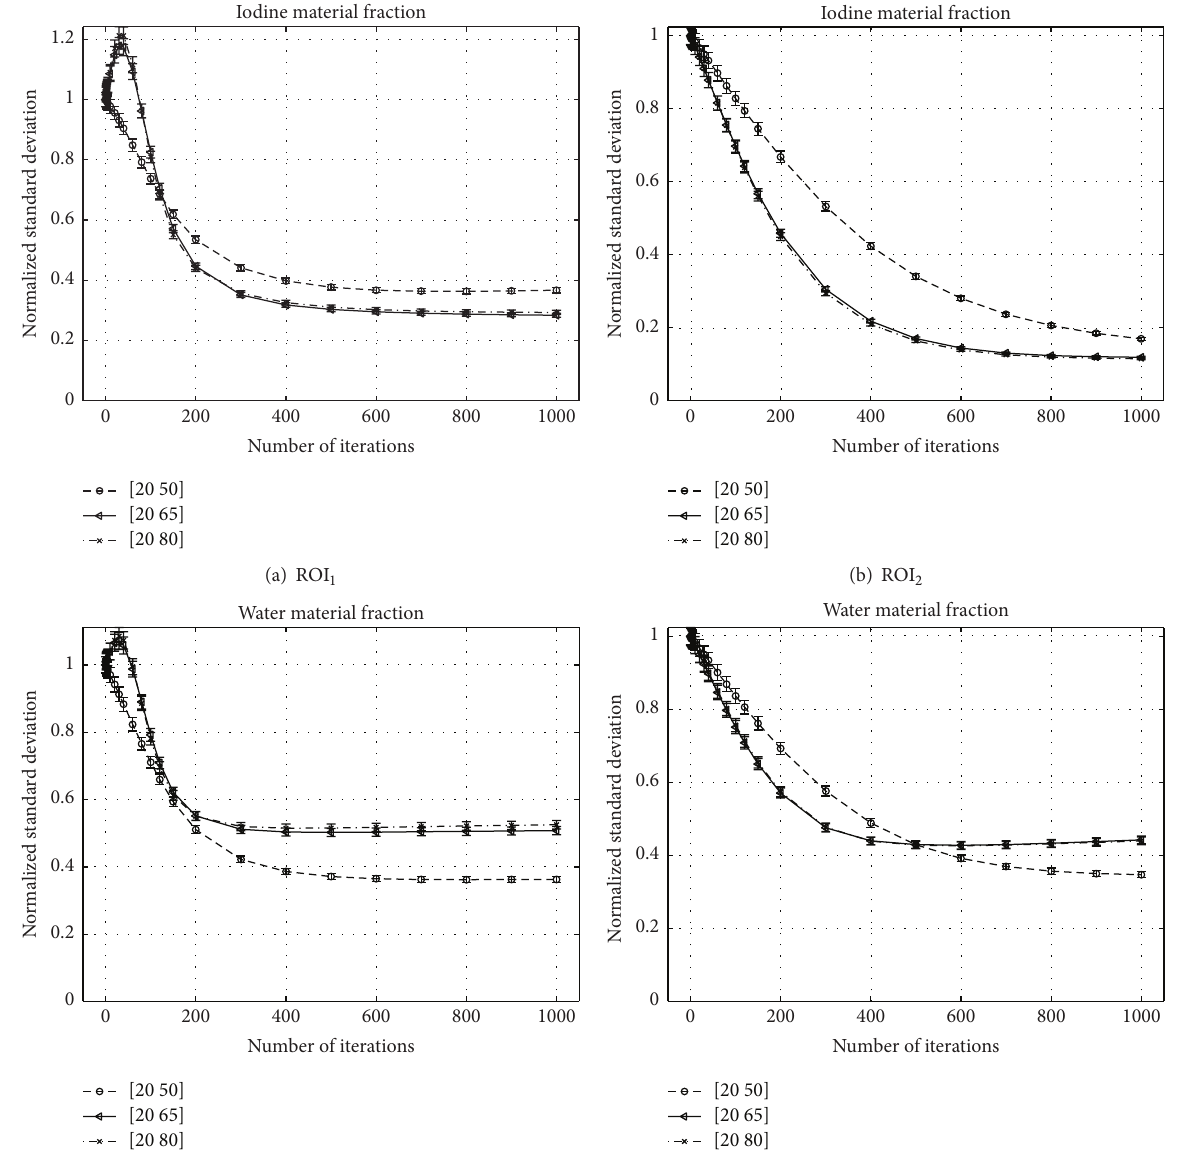
Figure 7: Normalized standard deviation, evaluated within the ROIs shown in Figures 4(a) and 4(b), respectively. The standard deviation is normalized to the standard deviation measured in the initial iodine or water image for the respective threshold